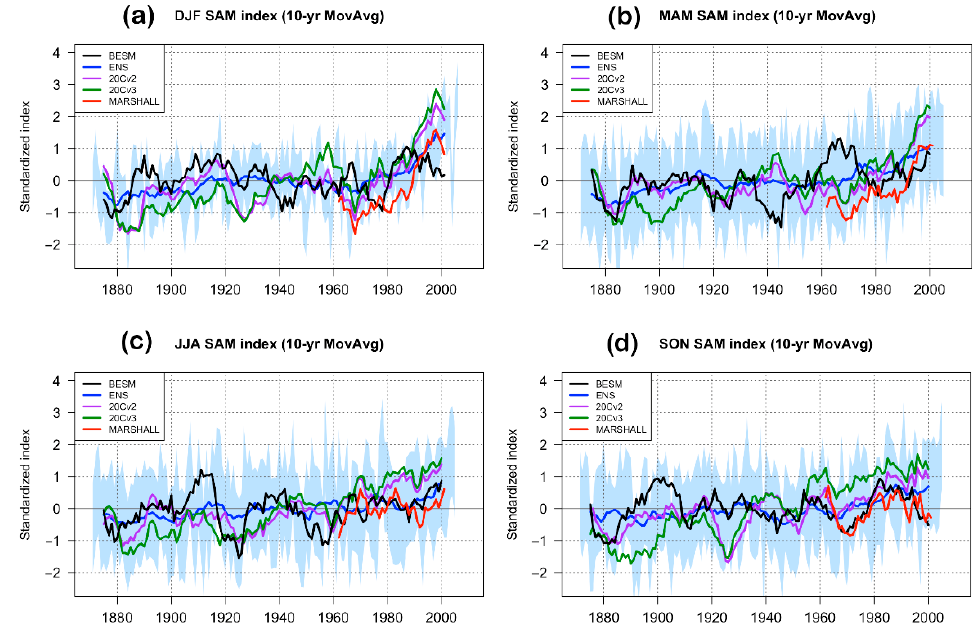
Figure 2. SAM GW99 index seasonal reconstruction from 1871 to 2005, compared with observations-derived Marshall index (red lines, available since January 1957). ( a ) austral summer (DJF); ( b ) austral autumn (MAM); ( c ) austral winter (JJA); and ( d ) austral spring (SON). Black lines: BESM; blue lines: CMIP5 ensemble mean; purple lines: NOAA-20Cv2 reanalysis; green lines: NOAA-20Cv3 reanalysis. SAM indices time series were smoothed by a 10-yr moving average. Light blue shaded area corresponds to 2 standard deviations of the ensemble mean (blue line).